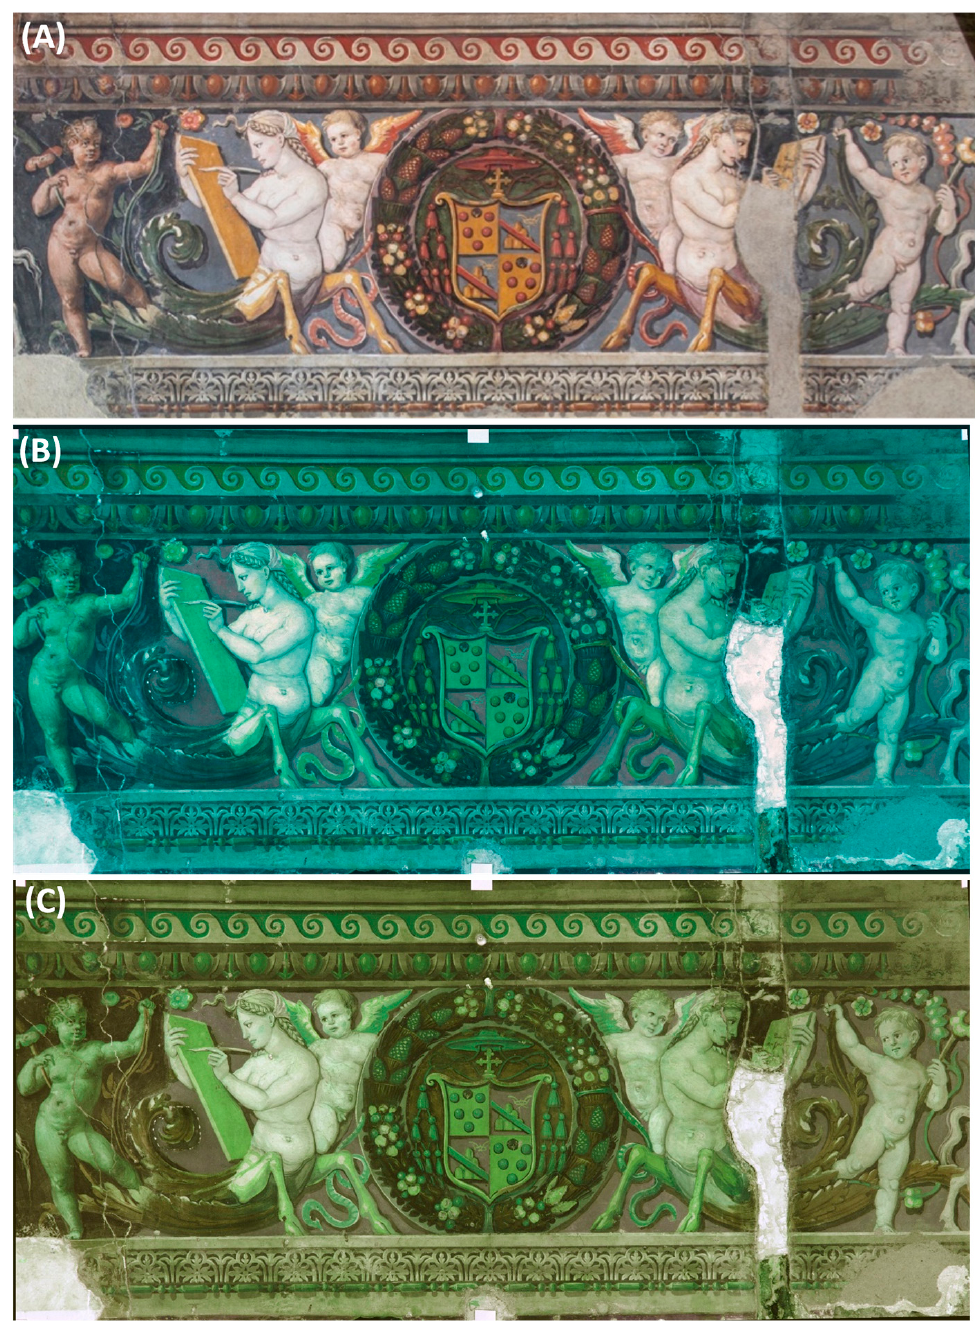
Figure 8. RGB ( A ), IRFC ( B ), and UVFC ( C ) images of the frieze after the complete removal of the scialbo , obtained with PickViewer ® .